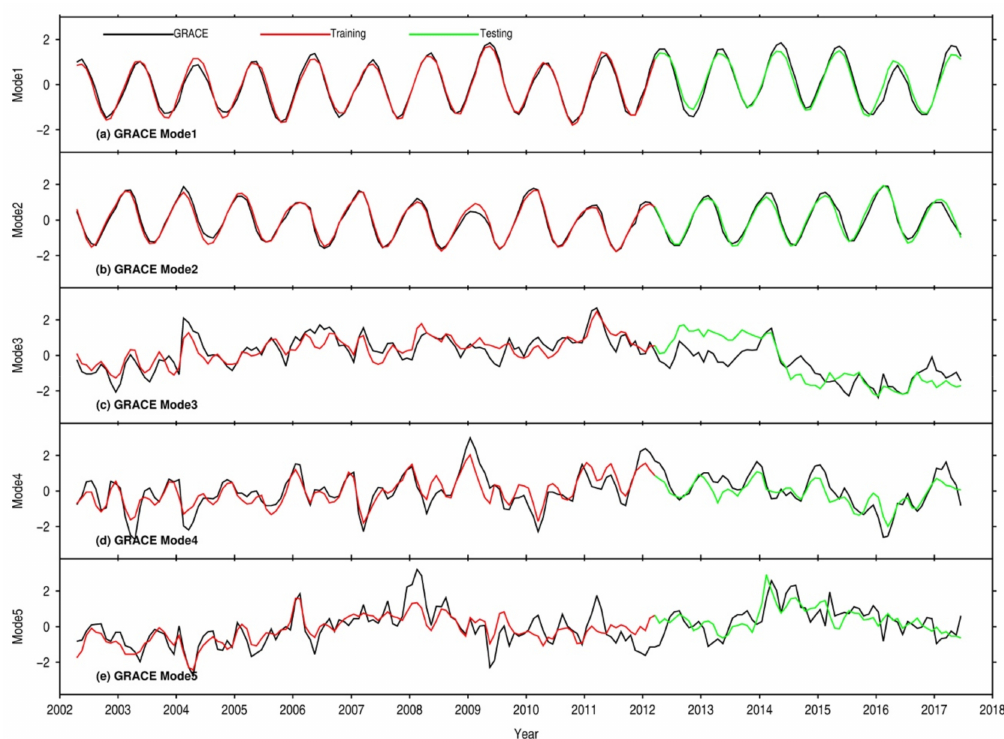
Figure A4. Five leading GRACE temporal modes (black lines) relative to the composed ones in the training (red lines) and testing periods (green lines).